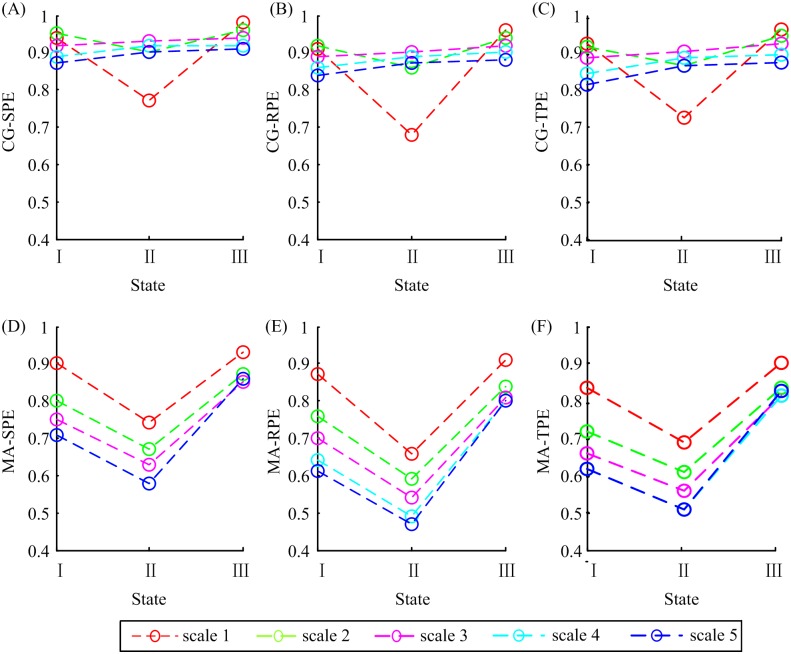
The median values of six MSPE indexes in awake state (I), unconsciousness (II) and RoC state (III).The circles symbolize the median values and different colors represent different decomposition scales.